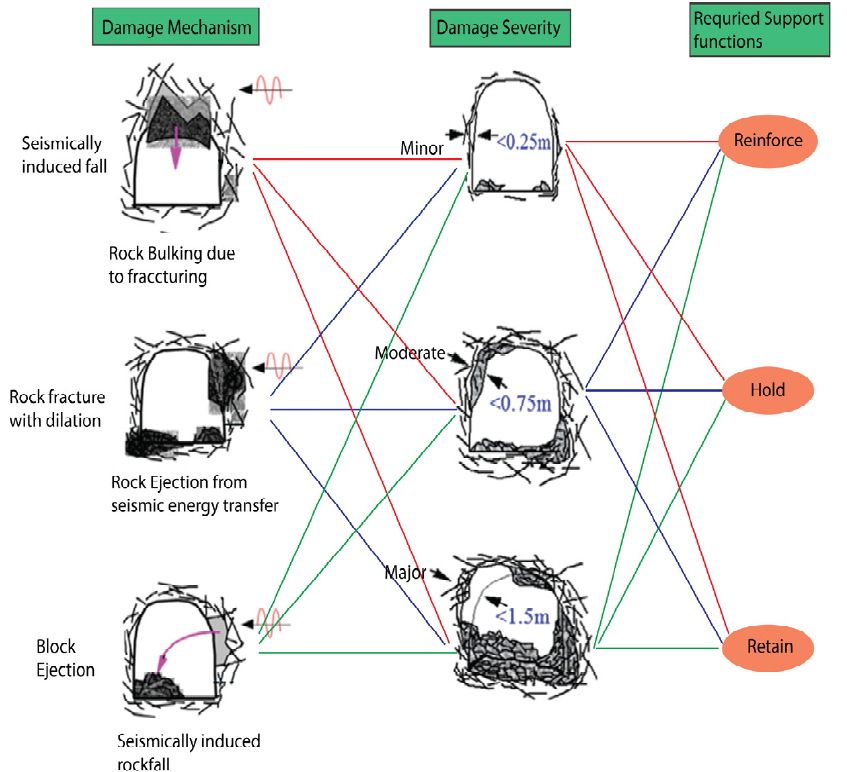
Figure 1. Types of rockburst damage mechanisms and damage severity (modified from ref. [7]). Table 2. Classification of rockbursts